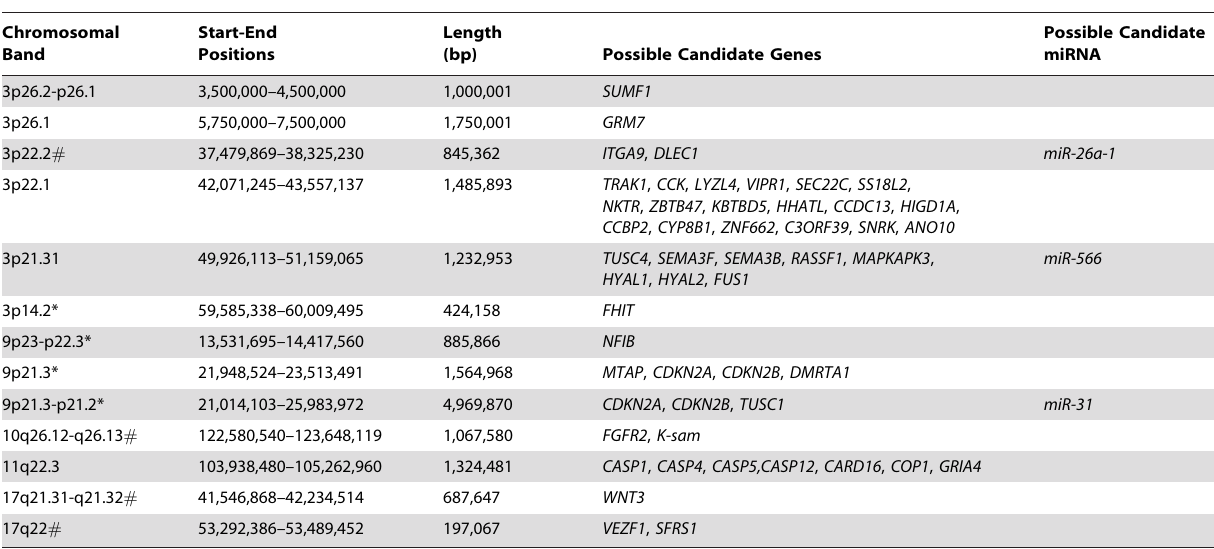
Table 3. The smallest recurrent aUPD regions in TN tumor